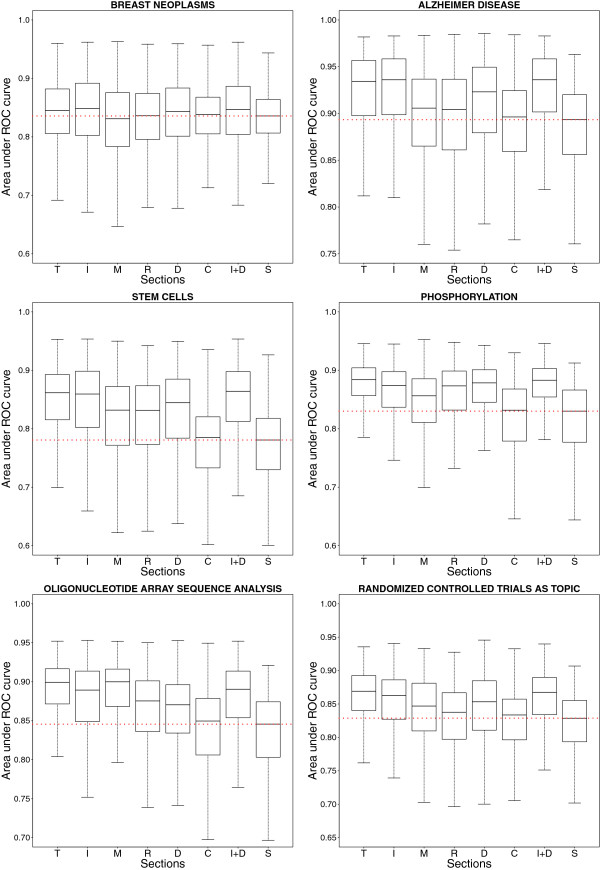
Classification of topics-related documents. In this classification task, the algorithm ranked documents with a given MeSH term annotation with respect to random documents using the references cited in the document and present in the full document or its sections. The median ROC area obtained when training only with the document of interest (S, the baseline) is indicated (dotted line). T: total (or full document), I: introduction, M: methods, R: results, D: discussion, C: conclusion, and I+D: introduction and discussion, ROC: receiver operating characteristic.